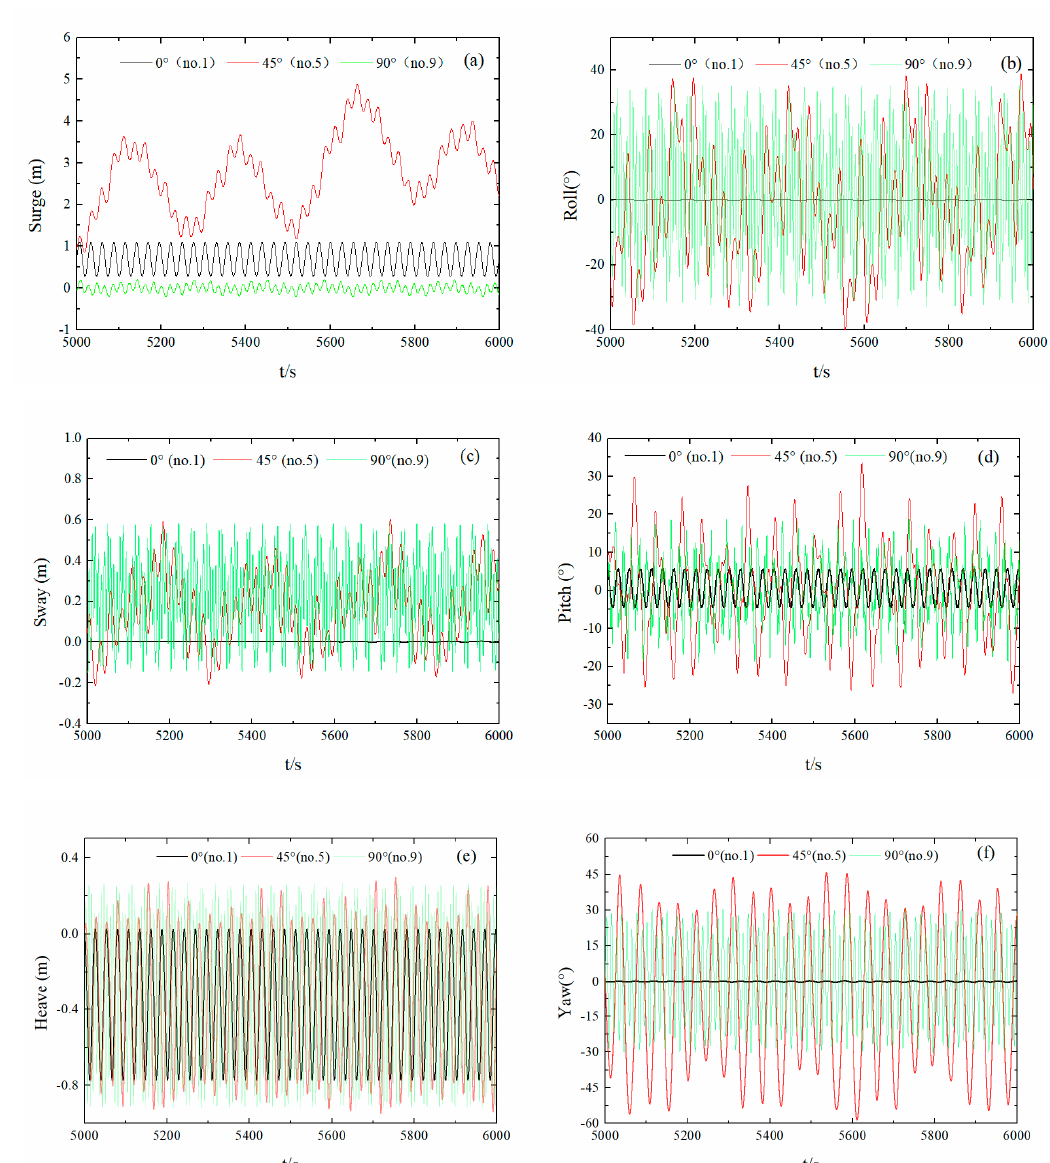
Figure 13. 6DoF time-history motion curves of the float with different wave angles. (Sub-figures: ( a ) surge motion curves; ( b ) roll motion curves; ( c ) sway motion curves; ( d ) pitch motion curves; ( e ) heave motion curves; ( f ) yaw motion curves.).